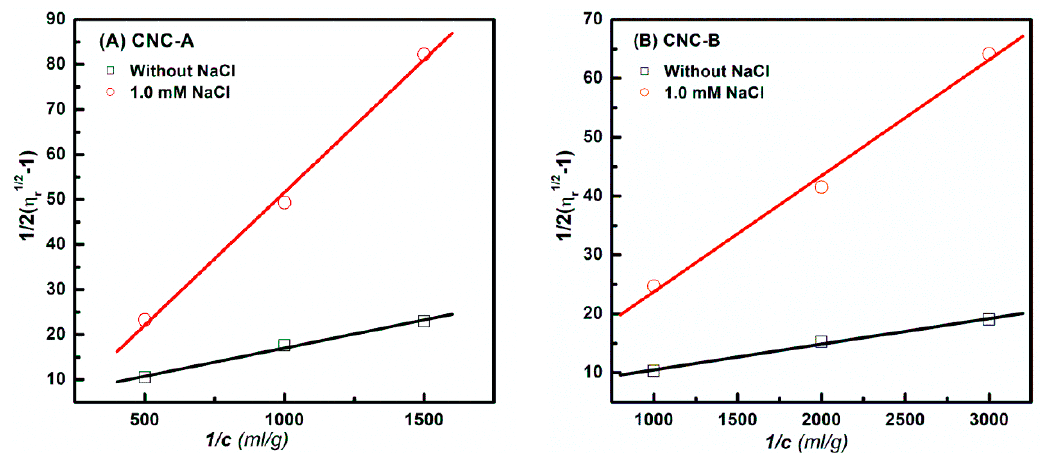
Figure 3. Fedors plots for ( A ) CNC-A and ( B ) CNC-B suspensions with and without 1.0 mM NaCl. Table 1. Intrinsic viscosities and calculated L / d of CNC-A and CNC-B without and with 1.0 mM NaCl. CNC-A Concentration NaCl (mM) Concentration (mM)